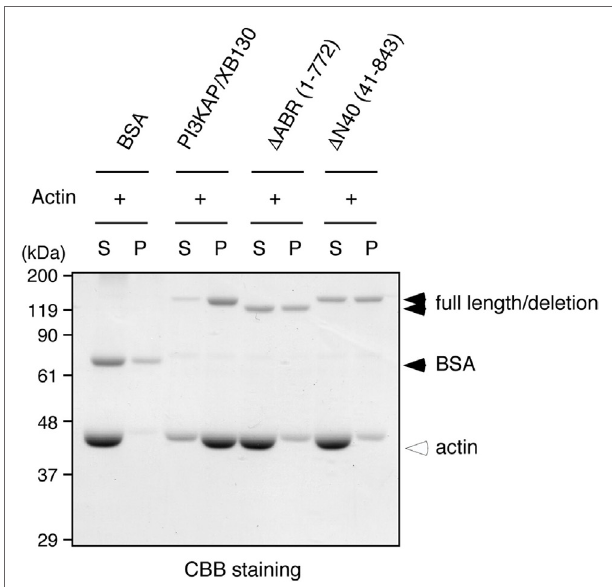
FigUre 5 | actin crosslinking by Pi3KaP/XB130 requires the dimerizing region and actin-binding region . Actin filaments polymerized in vitro were incubated with BSA, full-length PI3KAP/XB130 or the deletion mutants ( Δ ABR or Δ N40). The mixture was subjected to low-speed centrifugation, and the fractions of supernatant (S) and pellet (P) were separated by SDS-PAGE and then proteins were visualized by CBB